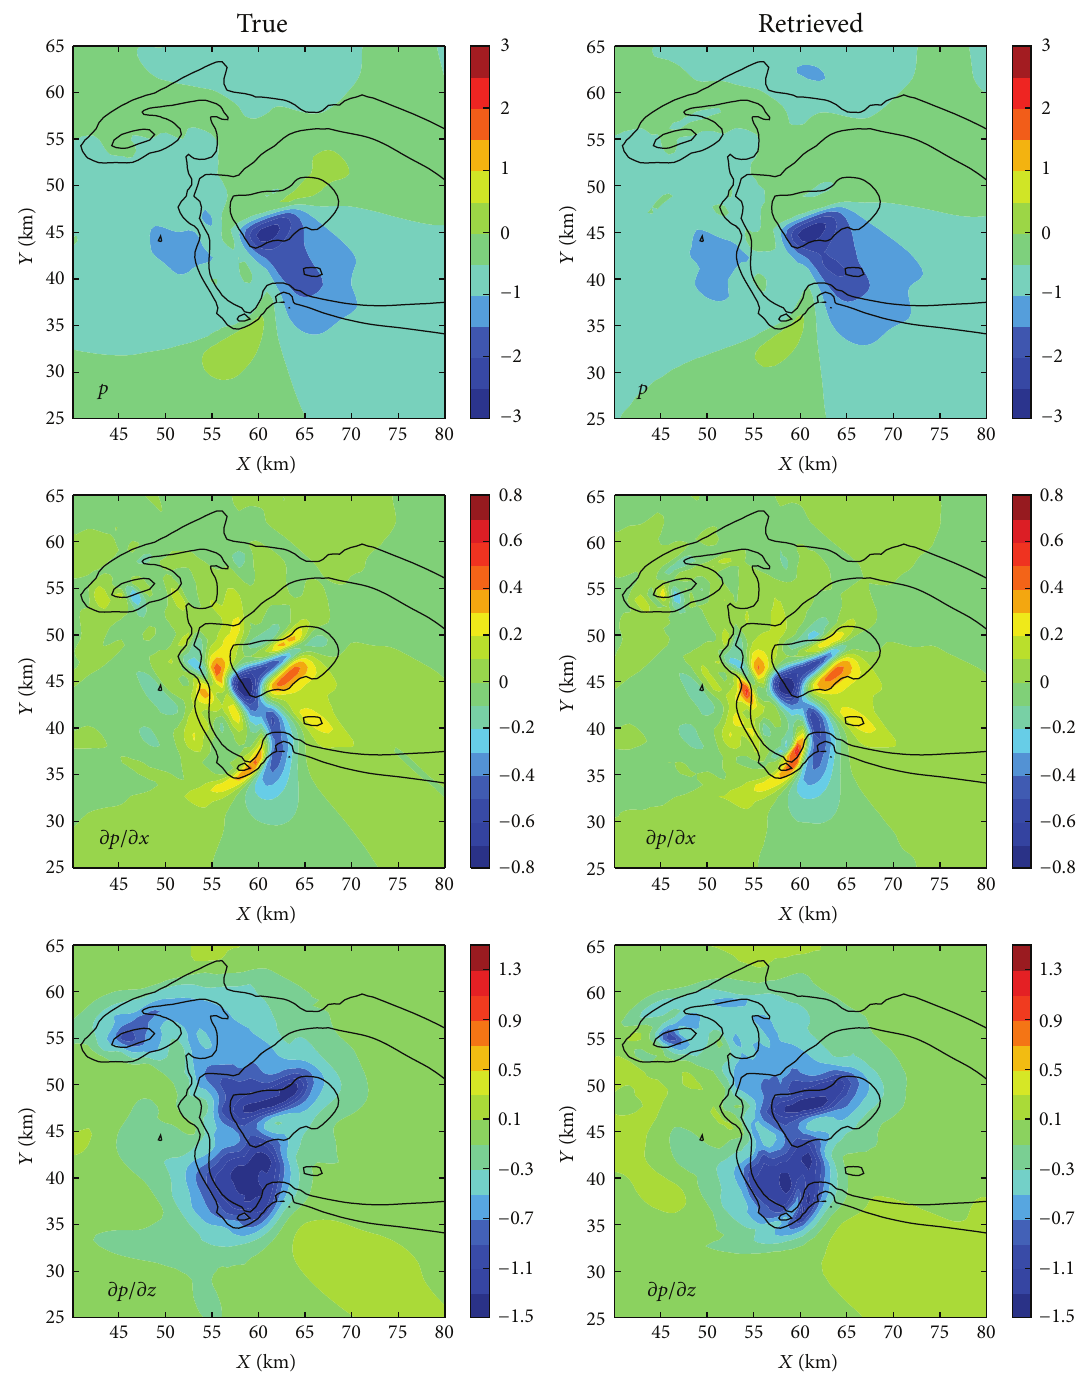
Figure 6: As in Figure 2 except for Δ𝑡 = 120 s in the pressure retrieval.